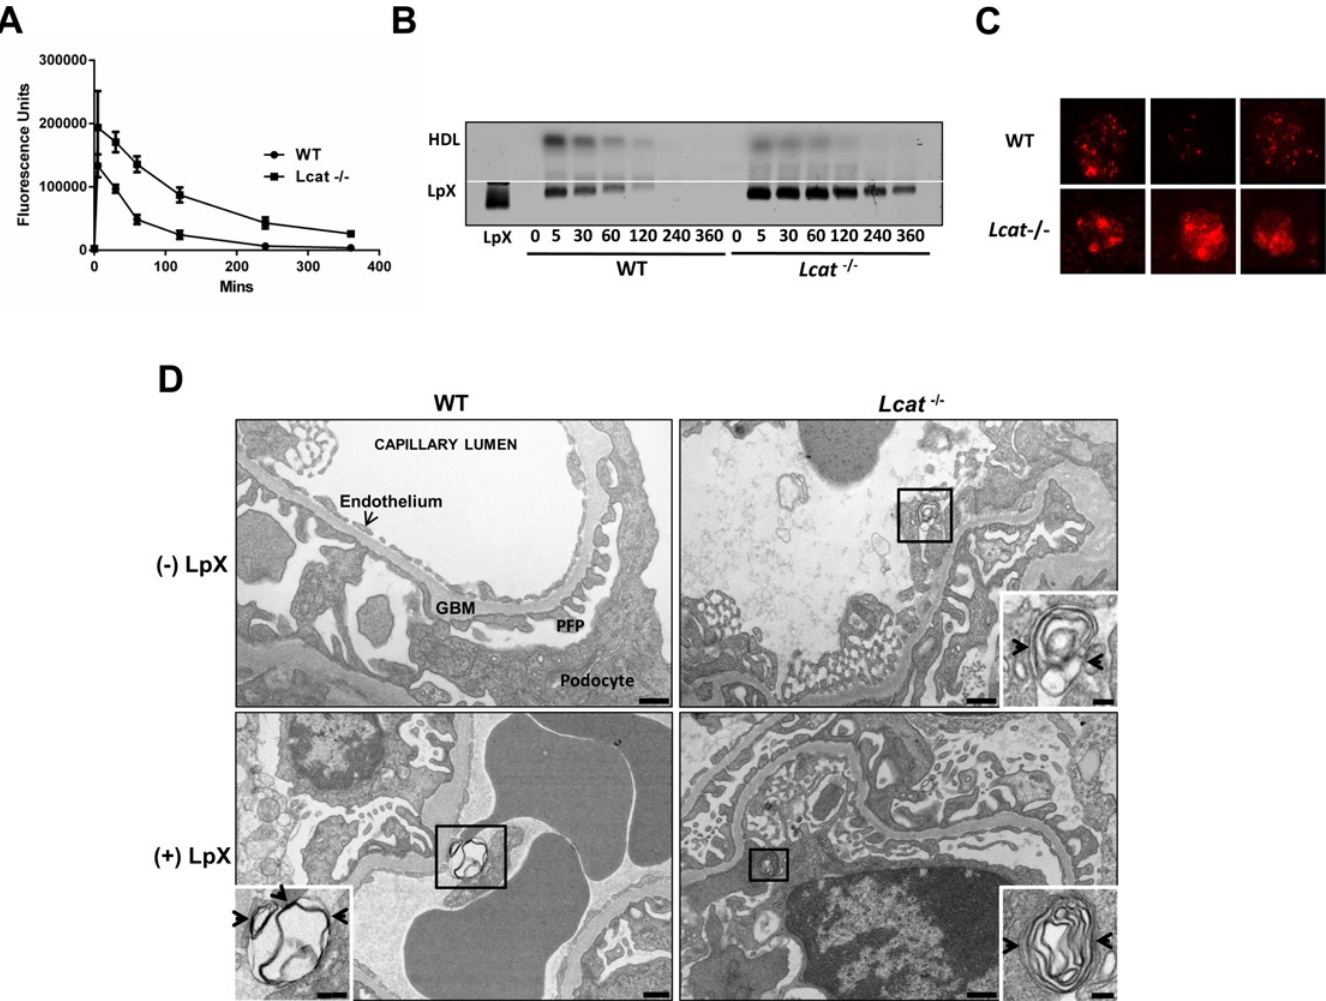
Fig 2. LpX plasma clearance and glomerular upake in vivo . LCAT deficiency markedly decreases LpX plasma clearance. WT and Lcat -/- mice were injected with lissamine rhodamine B PE-tagged LpX and plasma samples were taken at the indicated times. (A) Plasma-associated fluorescence. Each data point represents the total fluorescence of pooled mouse plasma samples (mean ± S.D.; n = 3). (B) Agarose gel electrophoresis of pooled mouse plasma lipoprotein PE fluorescence (same samples as in (A)). LpX cleared from WT plasma by 240 min, whereas Lcat -/- LpX remained elevated at all times. HDL- associated fluorescence was increased in WT plasma. W hite line indicates origin. (C) Fluorescent LpX retention in renal glomeruli is markedly increased in Lcat -/- mice. Representative confocal maximum projection images of 10 μ m fixed frozen kidney sections 4 hrs after injection of fluorescent-PE tagged LpX in mice chronically treated with 3 mg/wk synthetic LpX. Note the markedly increased retention of LpX in Lcat -/- mice glomeruli. (D) Electron microscopic analysis of LpX in renal glomerular capillaries. Representative TEM of renal glomerular capillaries in WT ( left panels ) and Lcat -/- mice ( right panels ). Endogenous multilamellar structures with features of LpX particles were occasionally present in the capillaries of (-) LpX Lcat -/- , but not (-) LpX WT mice. Synthetic LpX particles resembling endogenous LpX were frequently observed in renal capillaries of both (+) LpX WT and (+) LpX Lcat -/- mice. Both endogenous and exogenous synthetic LpX were often seen to be engulfed by endothelial cell processes ( insets ). Exogenous LpX in the capillary lumen bound to red blood cells in LpX-treated WT and Lcat -/- mice. GBM: Glomerular Basement Membrane; PFP: Podocyte Foot Process. Scale bars = 500nm. Inset scale bars = 250 nm (WT+LpX); 100 nm ( Lcat -/- ±